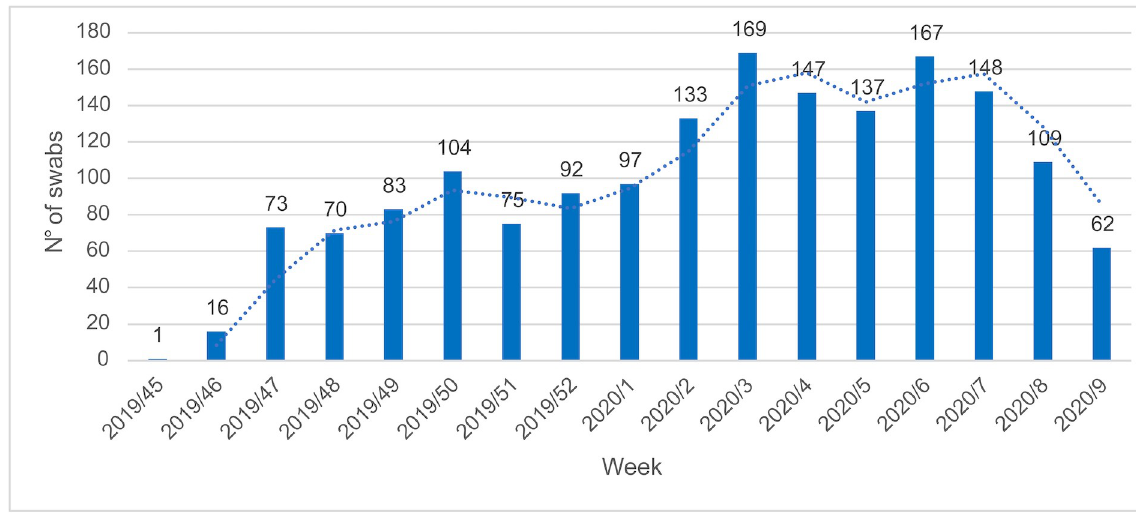
Fig 1. Number of swabs distribution by week during the study period.